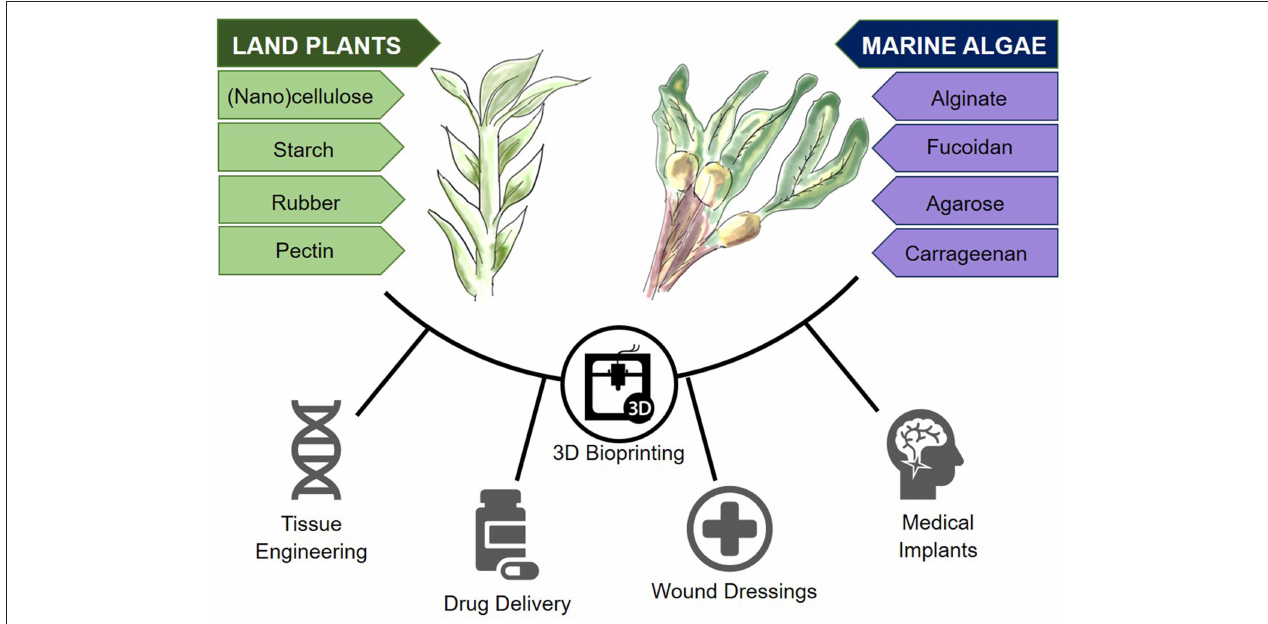
FIGURE 1 | Plant-derived biomaterials from land and marine sources and their potential in 3D